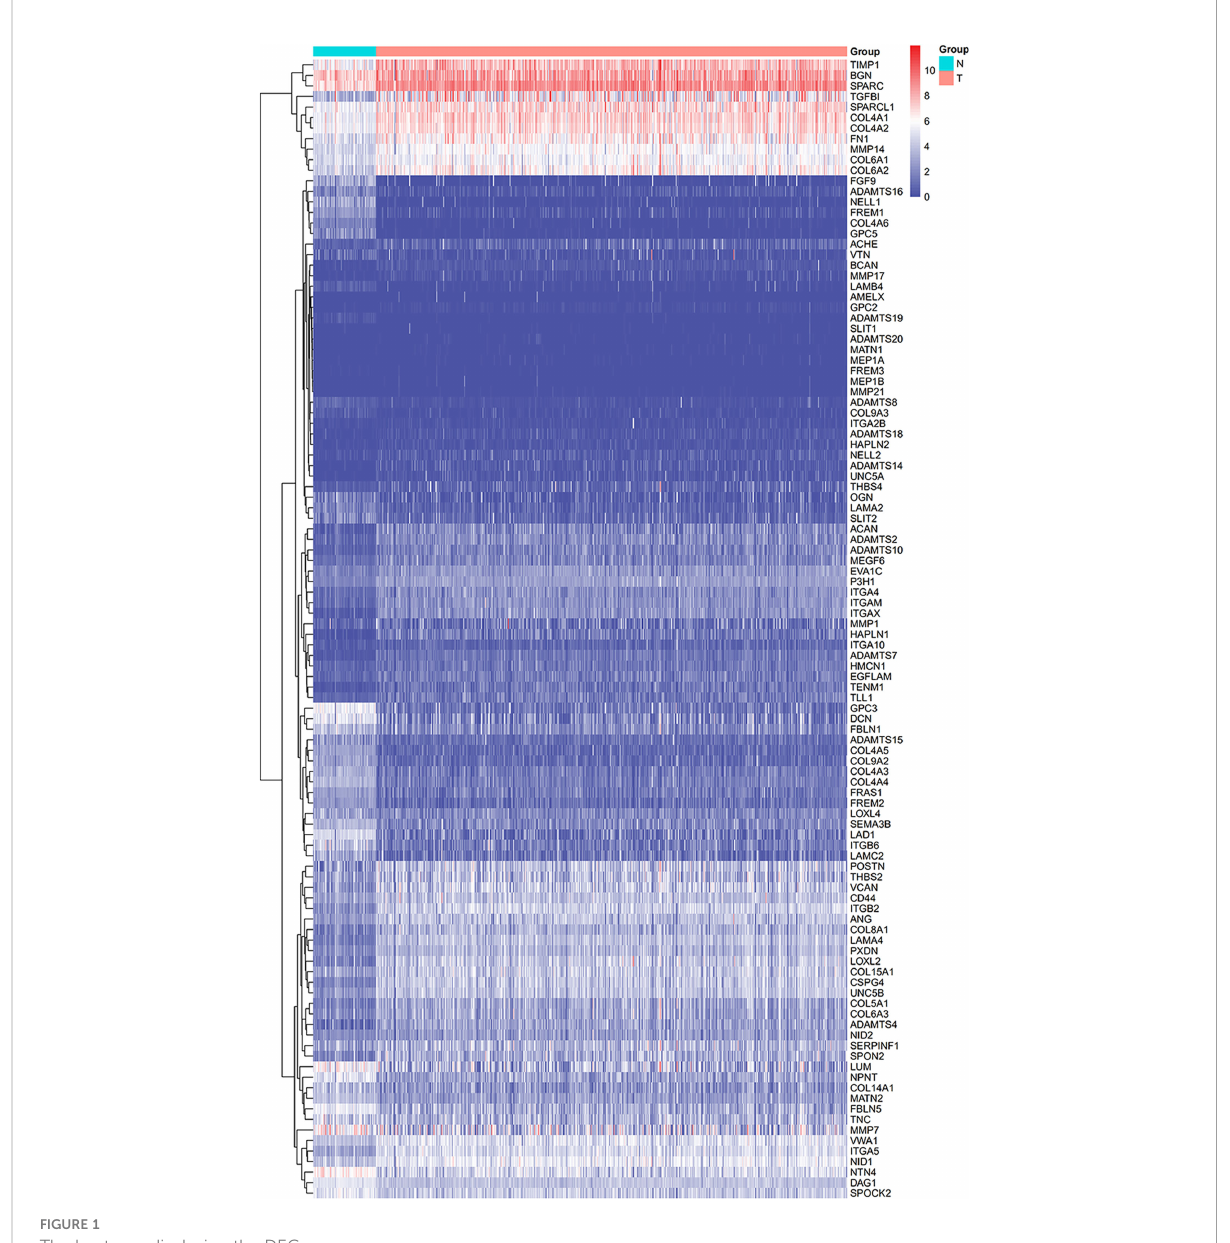
FIGURE 1 The heatmap displaying the